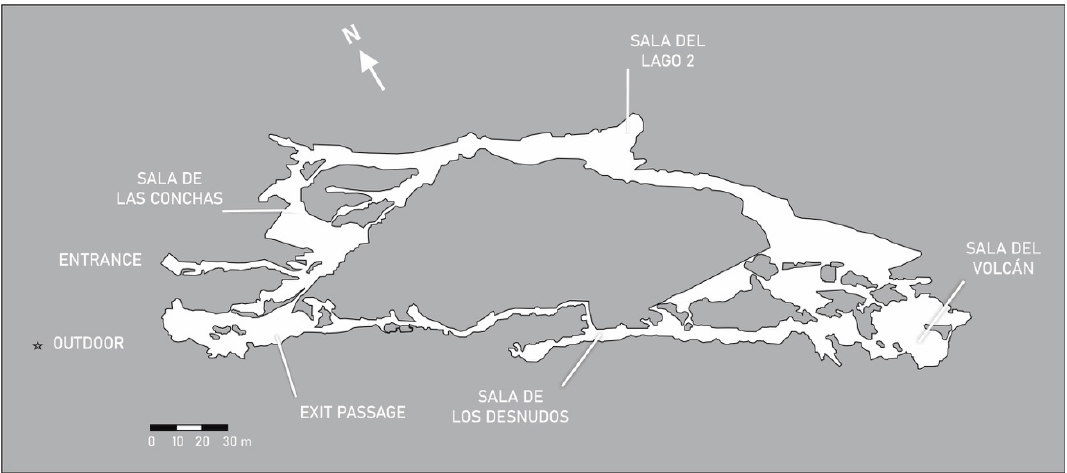
Figure 4. Map of Gruta de las Maravillas and sampling locations.